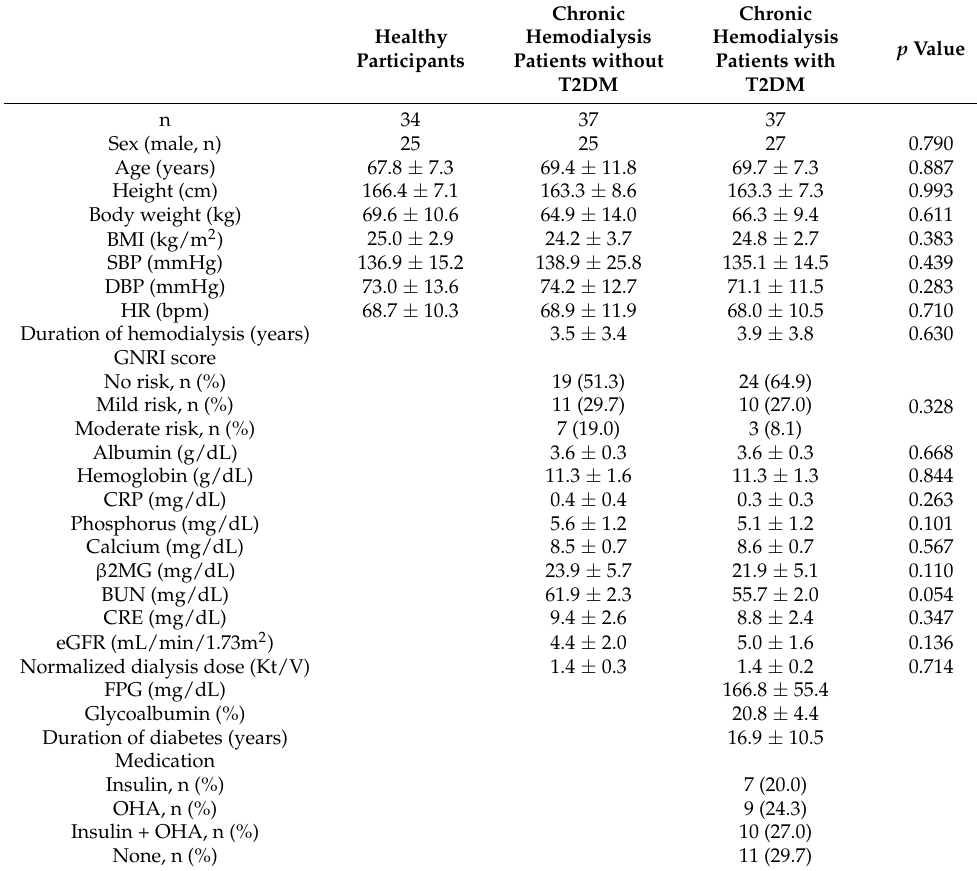
Table 1. Clinical characteristics of healthy participants and chronic hemodialysis patients with and without type 2 diabetes mellitus (T2DM).